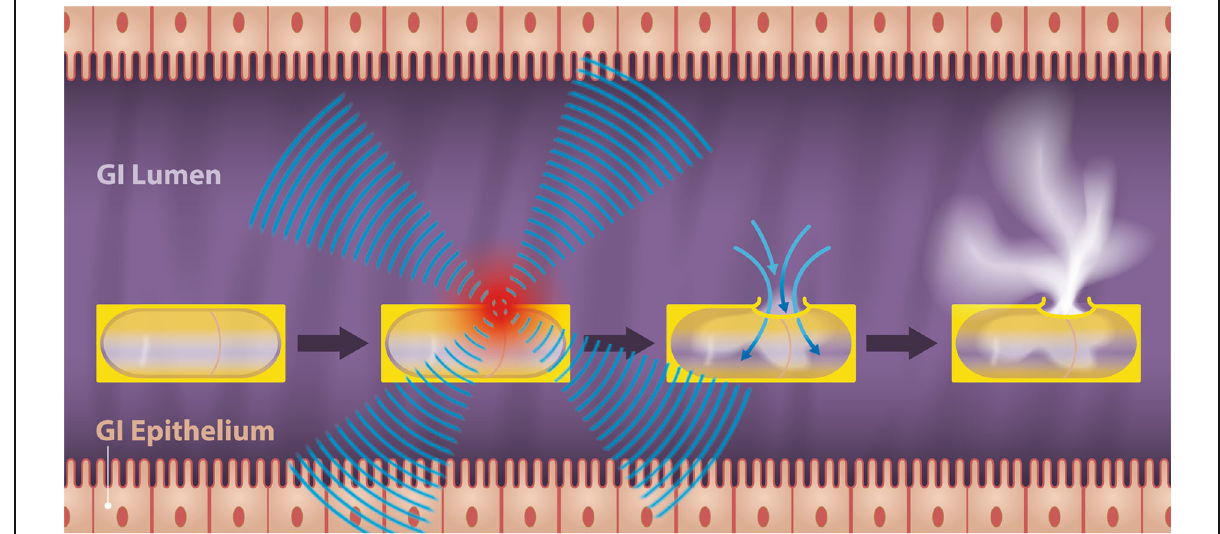
Fig. 2 Graphic description of the HIFU-triggered drug release of a wax-coated capsule. Conceptually, once the wax-coated capsule is in the body ( e.g. in the GI tract), it can be tracked due to its hypointensity on T2-weighted MRI (Fig. 5a). While the wax coating confers resistance to a premature release of the capsule content, its melting point can be designed to be low enough (in this study 43 °C) for a mild non-invasive external heat trigger ( e.g. by HIFU) to melt a cavity into the coating. Water influx from the gut lumen [59] into the capsule core dissolves the lyophilised GBCA, leading to a well-visible hyperintense signal (white cloud) on T1-weighted MRI. GBCA: Gadolinium-based contrast agent; GI: Gastrointestinal; HIFU: High-intensity focused ultrasound; MRI: Magnetic resonance